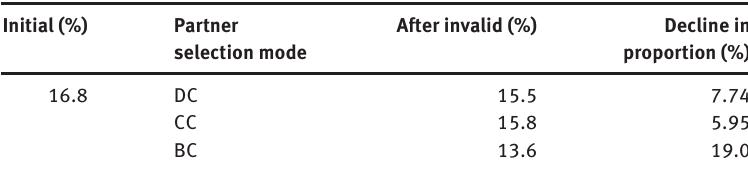
Table 3. Change of Network Efficiency of the OCCN by Three Centrality Indices. Initial